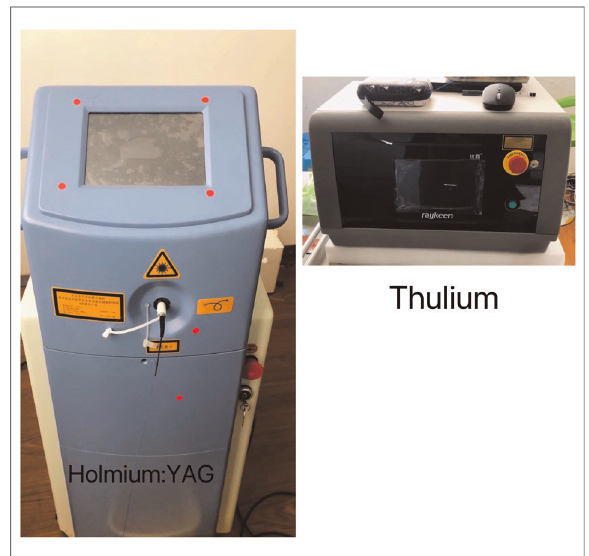
FIGURE 4 Laser generator of holmium:YAG and thulium. Usually, the body of laser generator of Holmium:YAG was larger than that of Thulium. And the latter seemed more effective in the plaques without severe calci fi